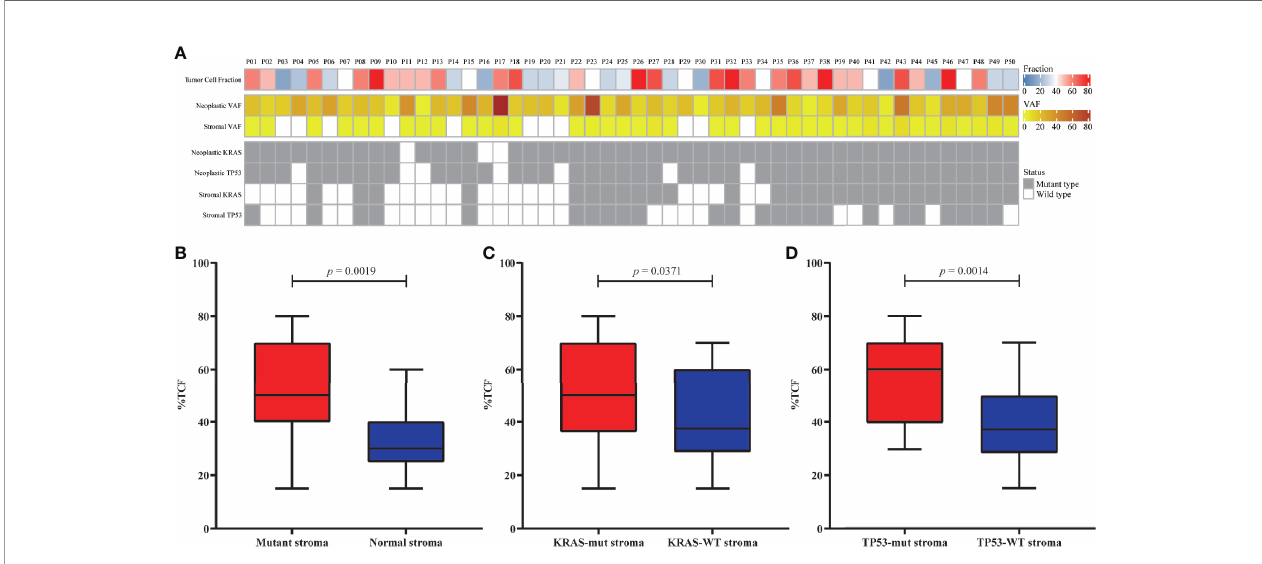
FIGURE 2 | Correlation between the tumor cell fraction (TCF) and genomic status. (A) Overview of the TCF, stroma/neoplastic VAF, and KRAS/TP53 status for each patient. (B – D) Comparison of the TCF from patients with mutant or normal stroma (B) , with or without KRAS mutation (C) , and with or without TP53 mutation (D) . VAF, variant allele